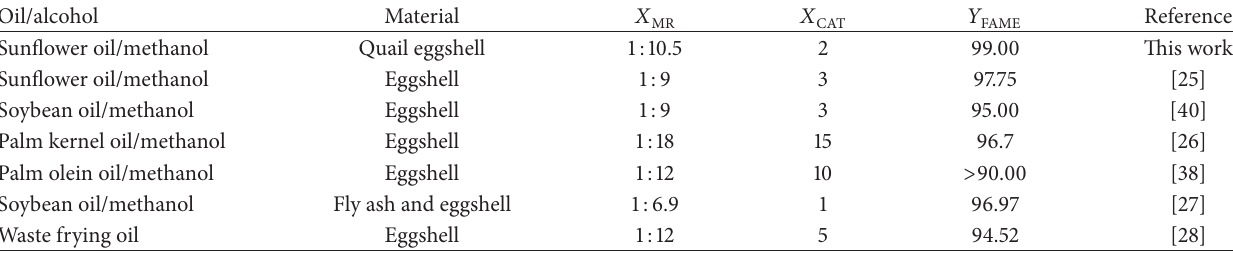
Table 4: Comparison of biodiesel production using different wastes eggshell catalysts in transesterification reaction. Oil/alcohol